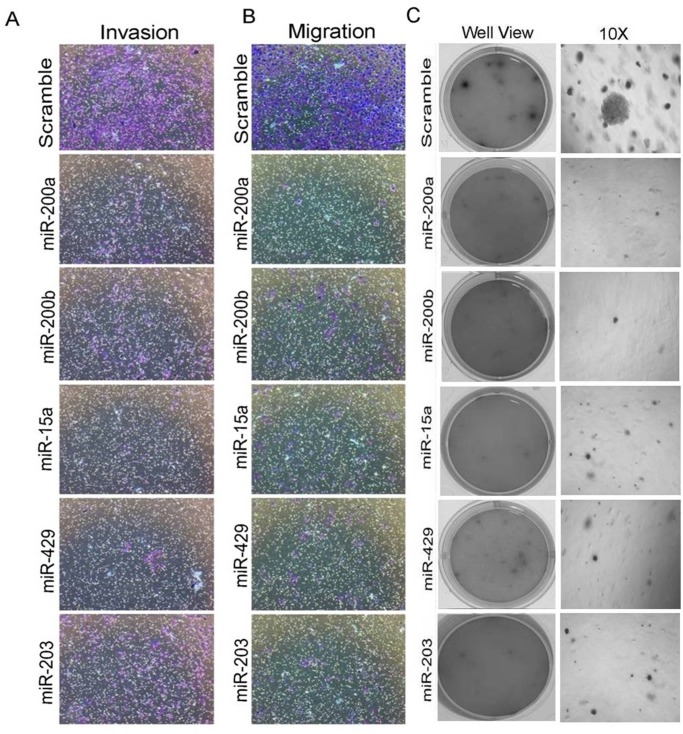
miRNAs inhibit migration, invasion and anchorage-dependent growth in MDAMB-231 cells.Migratory and invasive rolesin MDAMB-231 cells having overexpressed miRNAs(A, B). Soft agar assay in MDAMB-231 cells having over expressed miRNAs (no of replicates 3) (C).Scramble miRNA vector transfected cells were used as control. All the experiments were performed in triplicates and standard deviation is represented in error bars.